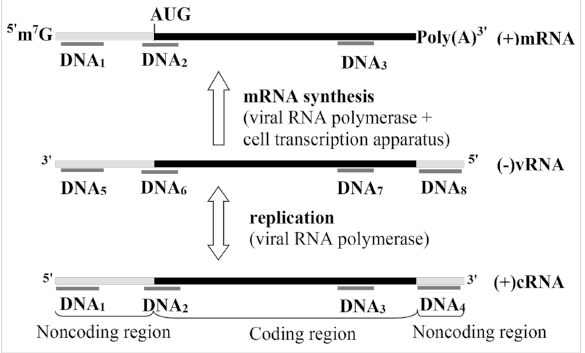
Figure 1: Scheme of localization of the used DNA fragments on influenza A virus segment 5. AUG is the initiation codon for translation of the nucleoprotein